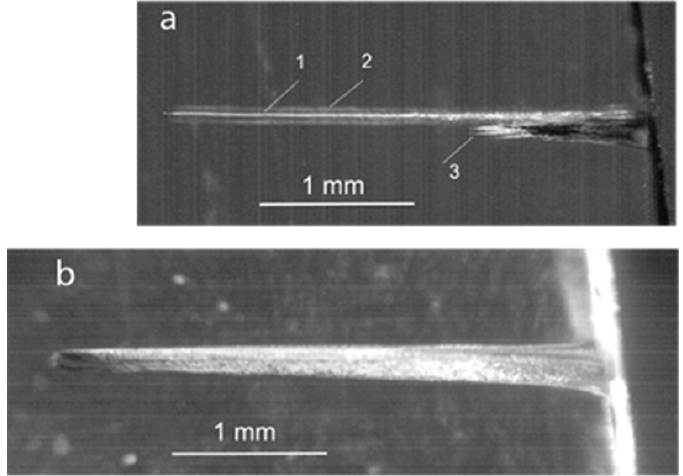
Figure 9. Microscopic images of channels drilled into K8 glass ( a ) by a train of pulses with E L = 2–4 mJ at a rep rate of 10 Hz for ~300 s, and ( b ) with E L ≈ 10 mJ at 40 Hz for ~ 180 s (not completed). The laser beam falls on the sample from the laser beam falls on the sample from the right.